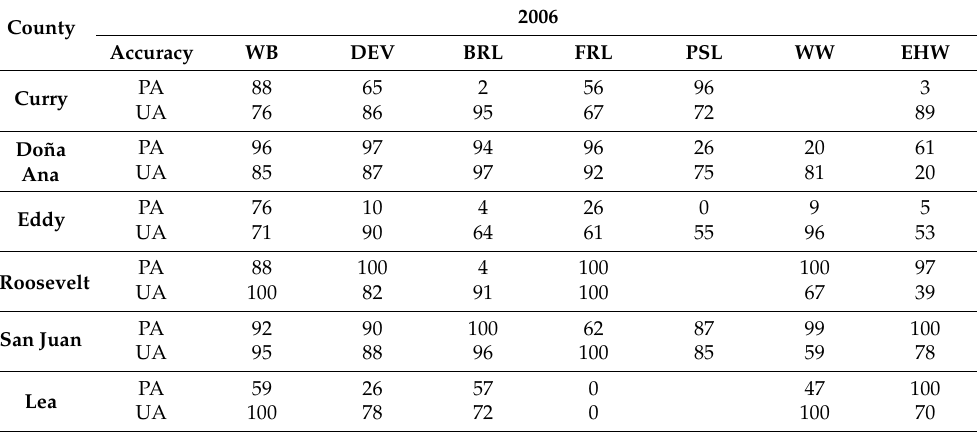
Table A4. User’s and producer’s accuracy for the rest of the LULC classes for the NLCD map of